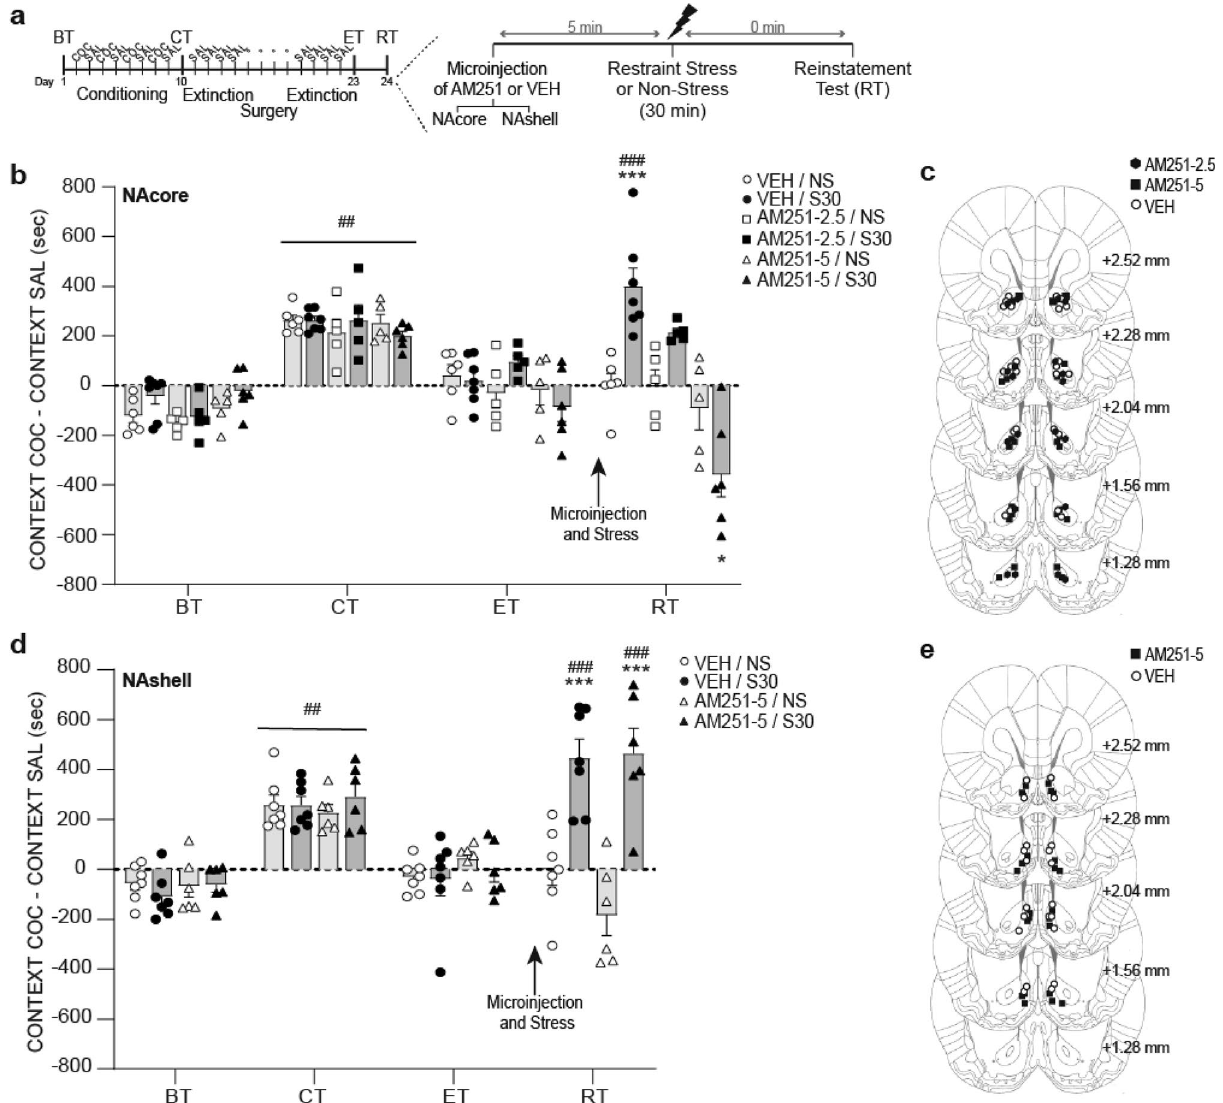
Figure 1. Stress-induced reinstatement of cocaine-CPP was blocked by CB1R antagonism in NAcore, but not NAshell. ( a ) Timeline of CPP procedure. Animals that met the extinction criterion received the intra-Nacore or intra-NAshell microinjection of vehicle (VEH) or a dose of AM251 (2.5 or 5 nmol/0.5 μl/side, referred as AM251-2.5 or AM251-5) 5 min before the exposure to the restraint stress for 30 min (S30), or remained in their home cages during the same time period (non-stress, NS). ( b , d ) Difference in preference score measured in the cocaine- and the saline-associated context during basal (BT), conditioning (CT), extinction (ET) and reinstatement (RT) tests, using CPP LIADE software, version 1.2 (http:// www. liade. inv. efn. uncor. edu/) During the CT, no difference in preference score between groups was found within each experiment ( ## p < 0.001 compared to BT). Bars in dot plots represent mean ± s.e.m., n = 5–7 in each group. ( b ) Subjects microinjected with VEH into NAcore before restraint stress showed a significant increase in time spent in the cocaine- associated context during RT ( ### p < 0.001 compared to ET and ***p < 0.001 comparing with NS groups and AM251-5/S30 group in RT, Bonferroni’s multiple comparisons post-hoc test). Intra-NAcore administration of the highest dose of AM251 before restraint stress prevented reinstatement of cocaine-CPP (*p < 0.05 comparing with VEH and AM251-2.5 groups in RT, using a Bonferroni’s multiple comparisons post-hoc test). ( d ) Stress- induced reinstatement of cocaine-CPP was not prevented by the intra-NAshell administration of AM251 (***p < 0.001 compared with NS groups in RT; ### p < 0.001 compared with ET, Bonferroni’s multiple comparisons post-hoc test). ( c , e ) Schematic coronal sections of the rat brain, adapted from the stereotaxic atlas of Paxinos and Watson (2007), showing approximate bilateral locations of the microinjector tips in the NAcore ( c ) and NAshell ( e ) regions of rats included in the data